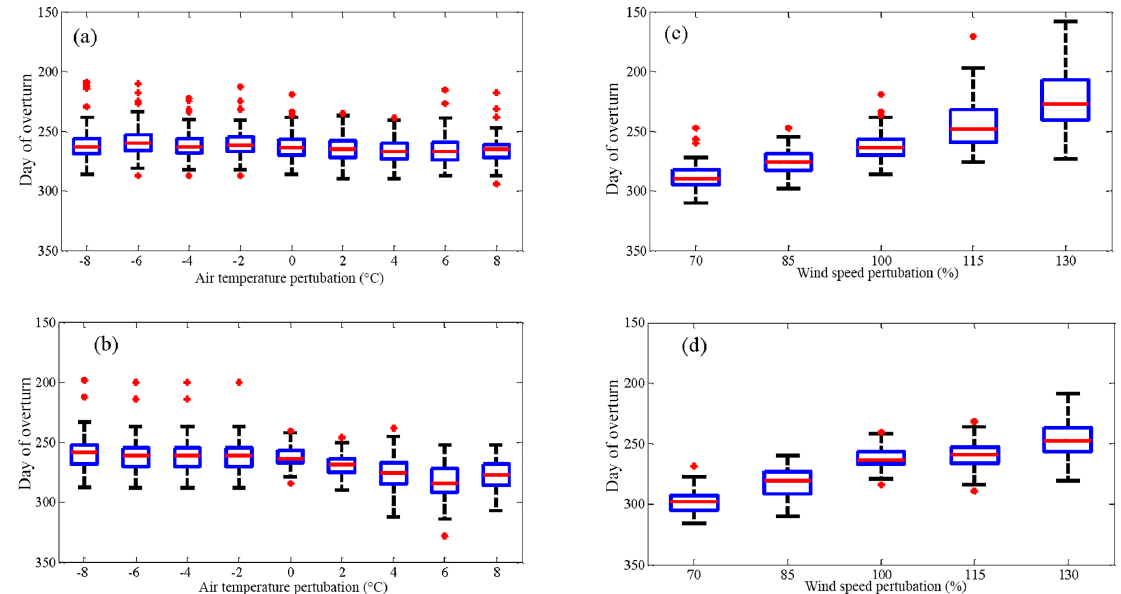
Figure 10. Day of stratification overturn under select air temperature perturbation scenarios for (a) Lake Mendota and (b) Fish Lake and day of stratification overturn under select wind speed perturbation scenarios for (c) Lake Mendota and (d) Fish Lake. The box represents the 25th and 75th quartiles and the central line is the median value. The whiskers extend to the minimum and maximum data points in the cases where there are no outliers, which are plotted